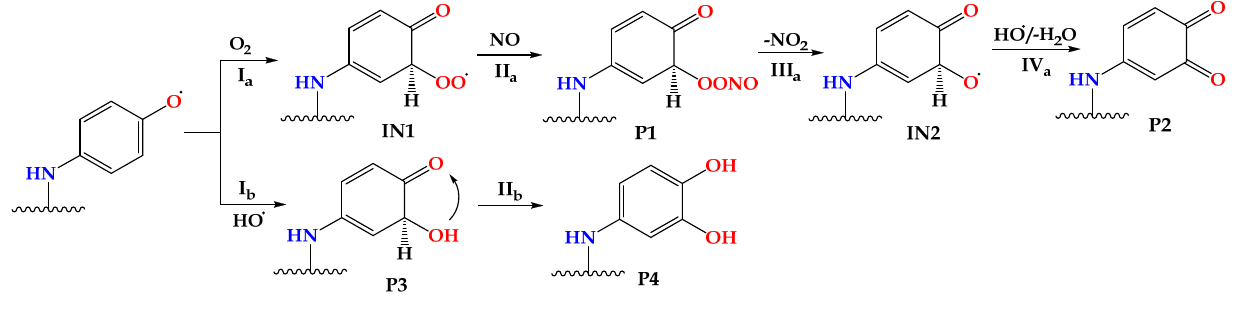
Figure 8. The proposed mechanism for the reaction between the formed radical species: A n –R • and O 2 /NO (Ia, IIa, IIIa, IVa) and A n – R • and HO • (Ib, IIb). Table 4. Estimated values of reaction Gibbs energies ( Δ r G ) in kJ·mol − 1 for reactions between the formed radicals A 1 − R • , A 2 − R • , and A 3 − R • and O 2 /NO in different sequential reaction pathways (I a , II a , III a , IV a ) or HO • (I b , II b ) at 298.15 K.